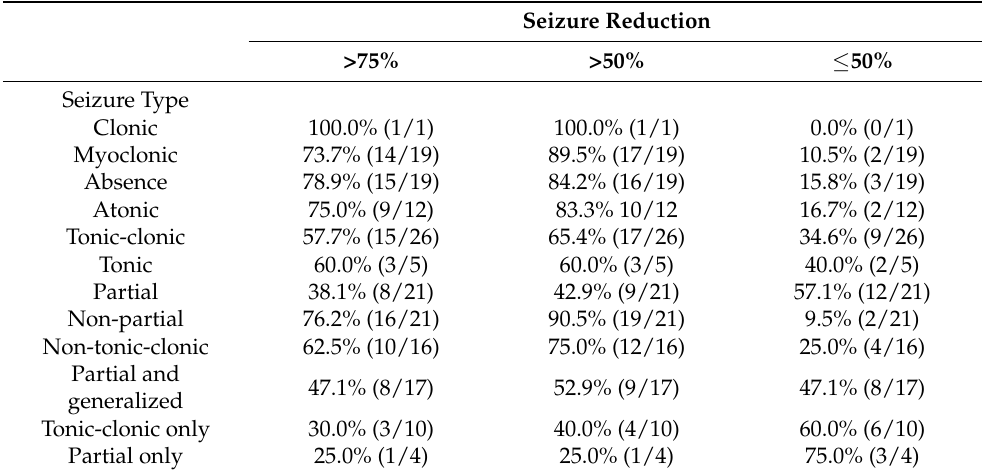
Table 3. The level of epileptic seizure reduction achieved after ketogenic diet therapy depending on the type of